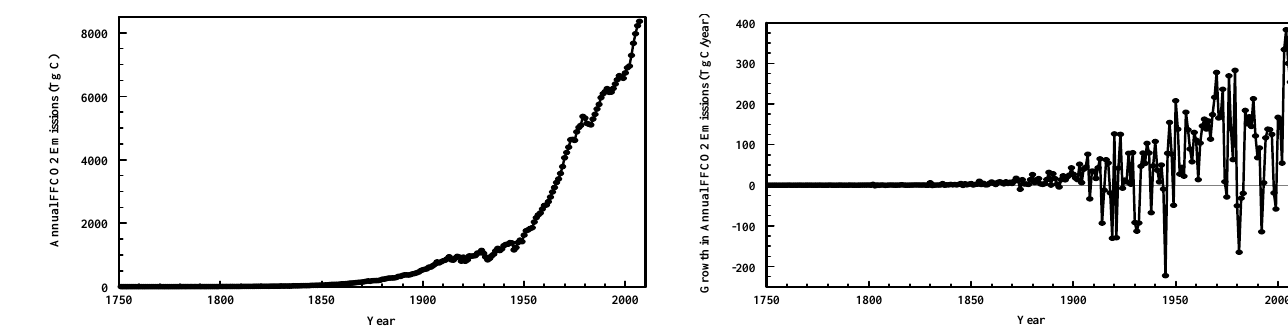
Fig. 3a. Annual FFCO2 emissions for the years 1751 to 2007. This figure was created from the sum of national production values (see section 1) for 15,830 country-year pairs. Data from Boden et al. (2010).